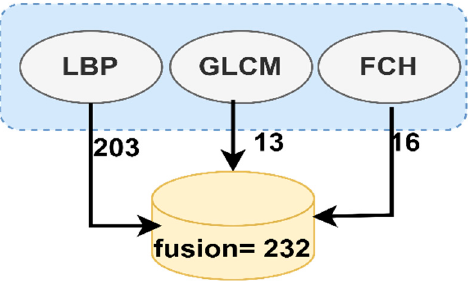
Figure 4. The fusion method between the three algorithms LBP, GLCM and